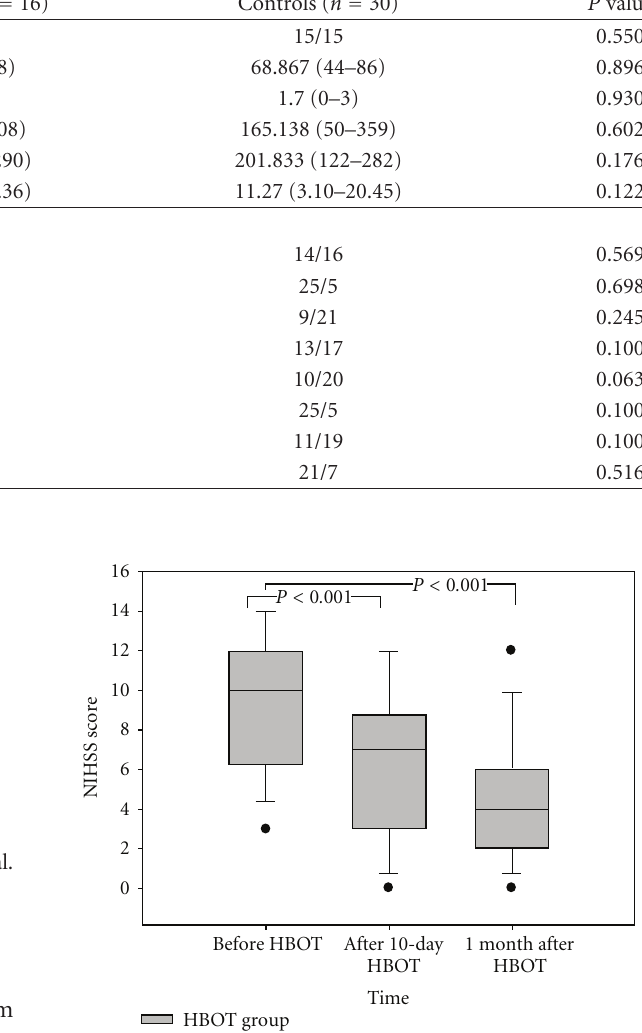
Figure 2: The clinical outcome (NIHSS score) in the HBOT group. The NIHSS scores were significantly decreased immediately after HBOT and after one month compared to the scores before HBOT ( P < 0 .